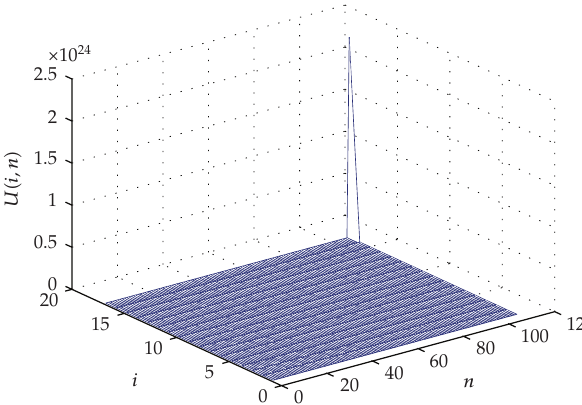
Figure 4: Evolution of the discrete solution, q (cid:2) 3, p (cid:2) 2 (cid:3) implicit scheme (cid:4)